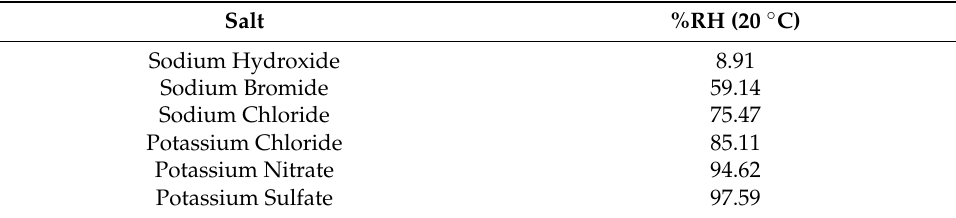
Table 1. Salts used for the saturated salt solutions and their respective RH [9].